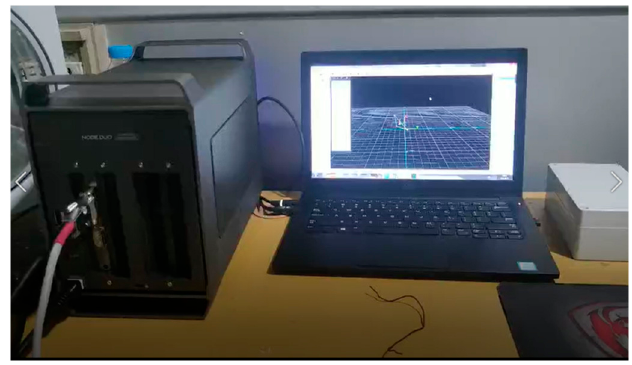
Figure 12. Experimental data acquisition system.